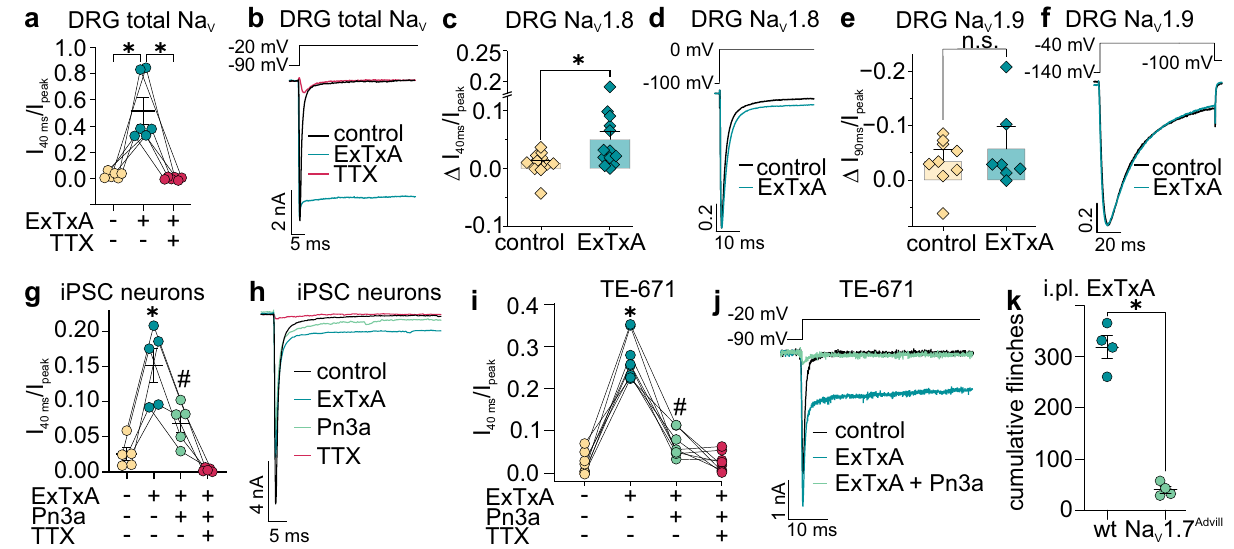
Fig. 1 | ExTxA inhibits Na V 1.7 inactivation in neurons and TE-671 cells. a Total persistentNa V currentinDRGneuronsafterperfusionofbuffercontrol(0.1%BSA), ExTxA (100nM) and ExTxA + TTX (1 μ M). ExTxA induces persistent Na V currents that are blocked by TTX. b Representative recording from a DRG neuron showing large TTX-s persistent current induced by ExTxA (100nM). c Change in persistent Na V 1.8 current ( Δ I 40 ms / I peak ; pre- and post-perfusion of buffer control (0.1% BSA) and ExTxA (100nM)) in DRG neurons from Na V 1.9 − / − mice in the presence of TTX (1 μ M). ExTxA slightly increased persistent currents of Na V 1.8 channels. d Representative normalized Na V 1.8 currents from buffer control (0.1% BSA) and ExTxA (100nM)-treated Na V 1.9 − / − DRG neurons. e Change in persistent Na V 1.9 current ( Δ I 90 ms / I peak ; pre- and post-perfusion of buffer control (0.1% BSA) and ExTxA (1 μ M)) in DRG neurons from Na V 1.8 − / − mice in the presence of TTX (1 μ M). ExTxA did not affect persistent currents of Na V 1.9 channels. f Representative